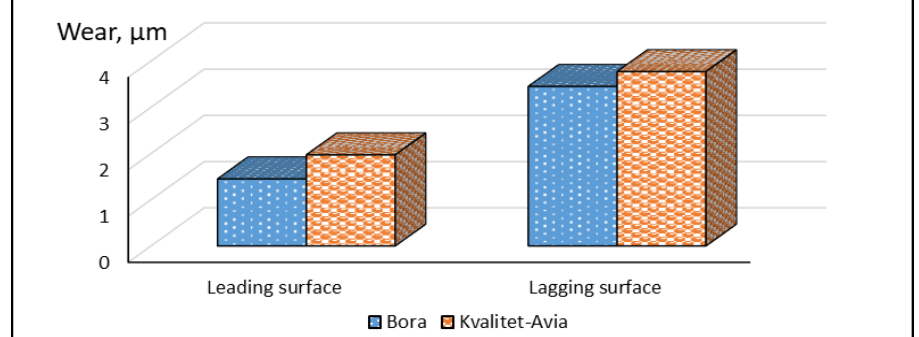
Fig. 6. Wear of contact surfaces in the course of